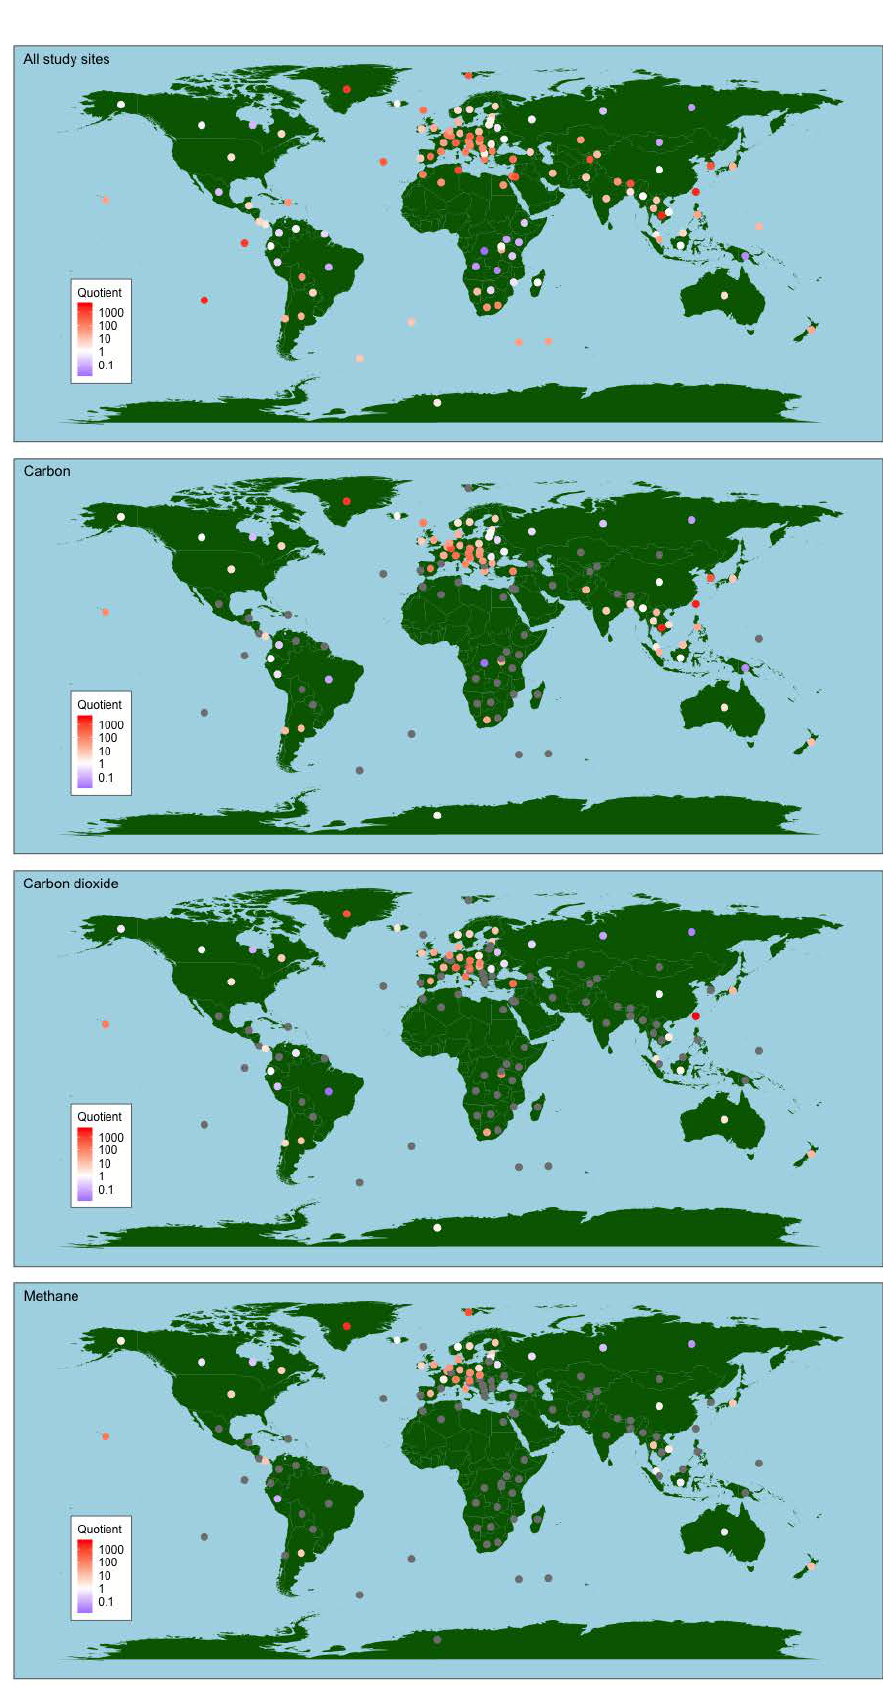
Figure 12. Global peatland study imbalances, as quantified by the quotient of the relative number of articles and the peatland area, per country/region, for all studies and the topics carbon, carbon dioxide and